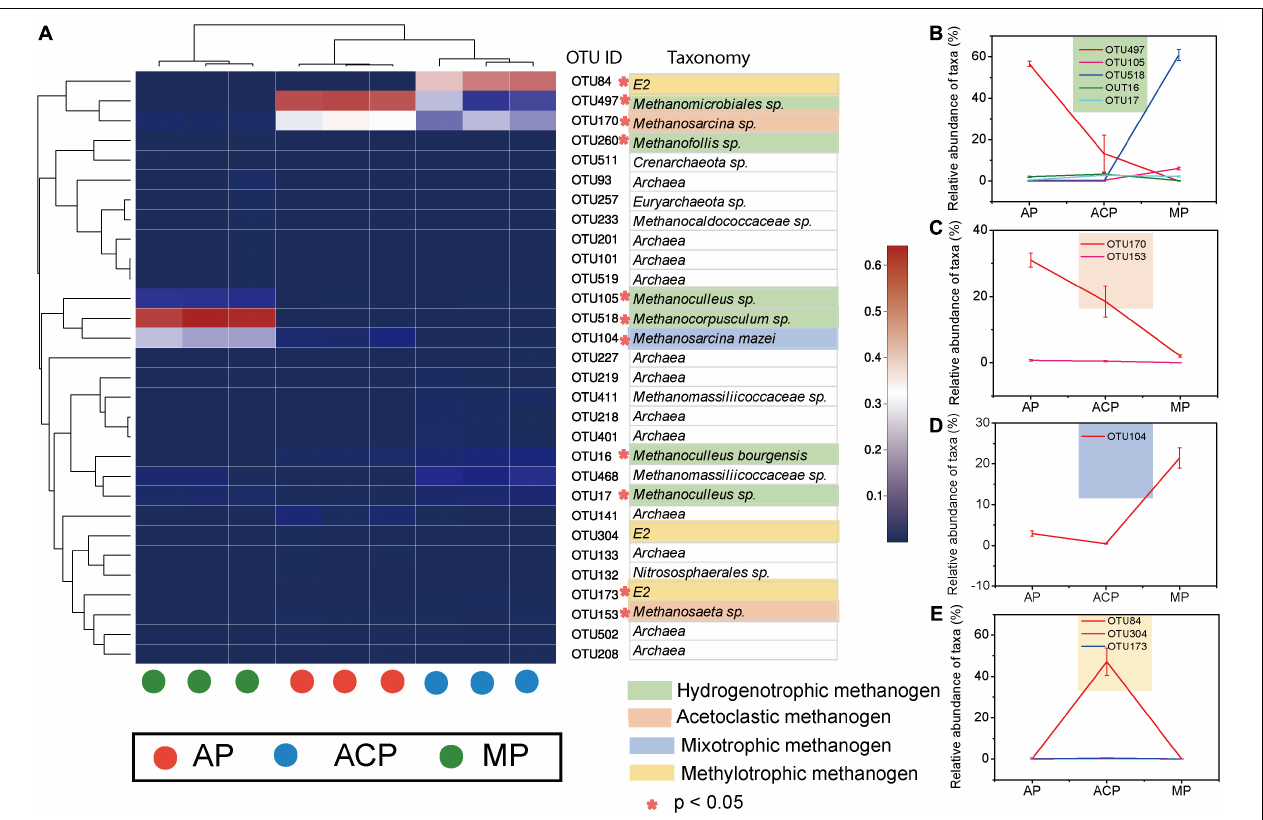
FIGURE 4 | The 30 most abundant OTUs (A) and main abundant OTUs (B–E) in response to solid waste decomposition. *The difference between the three phases was significant ( p < 0.05). AP, aerobic phase ( n = 3); ACP, anaerobic acid phase ( n = 3); MP, methanogenic phase ( n =